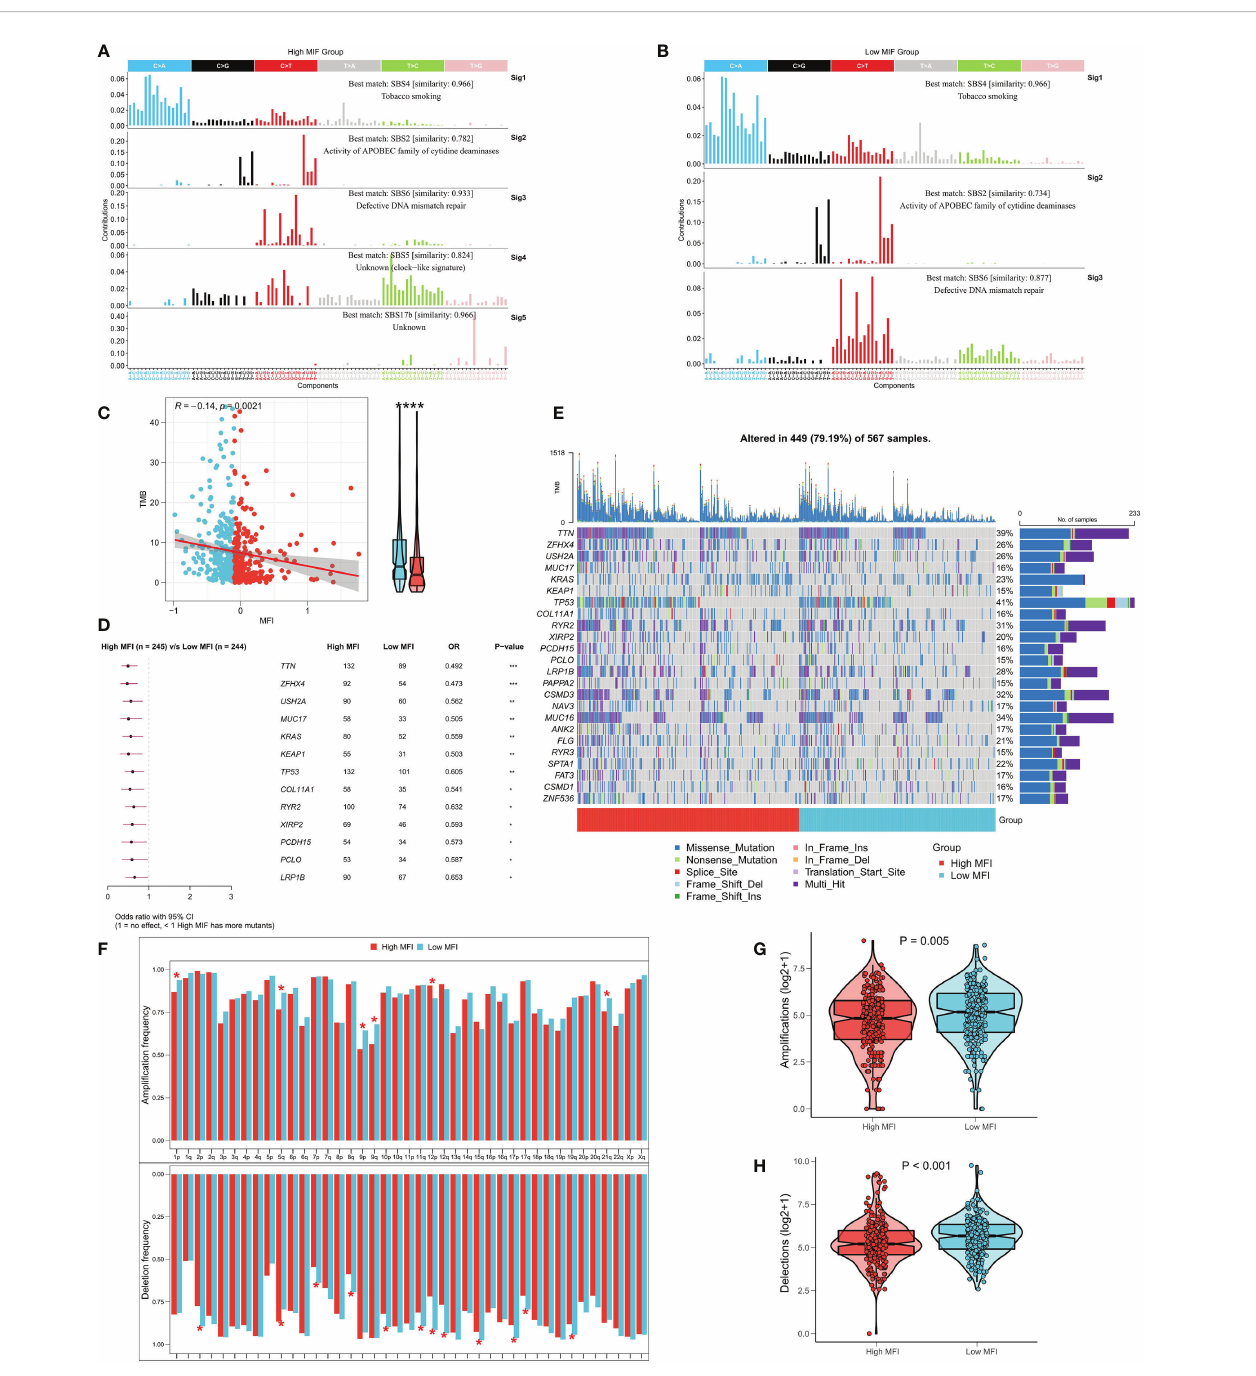
FIGURE 8 Correlation between MFI and genomic variation. (A, B) Mutation marker events in the high and low MFI groups, showing that smoking, APOBEC and DNA mismatch repair-related mutation events (SBS4, SBS2 and SBS6) were frequent in both high and low MFI groups. (C) Differences in TMB between the two subtypes, showing that MFI was signi fi cantly negatively correlated with TMB, and the latter was signi fi cantly increased in the low MFI group. (D) Forestplot showed the driver mutated genes with signi fi cantly higher mutation frequency in the low MFI group. (E) Oncoplot showed the mutation landscape of TOP24 mutation driver genes among subtypes. (F) Histogram revealed the CNV events on chromosome arms among subtypes. (G) Differences in overall ampli fi cation events between subtypes. (H) Differences in overall deletion events between subtypes. *P<0.5, **P<0.01, ***P<0.001,